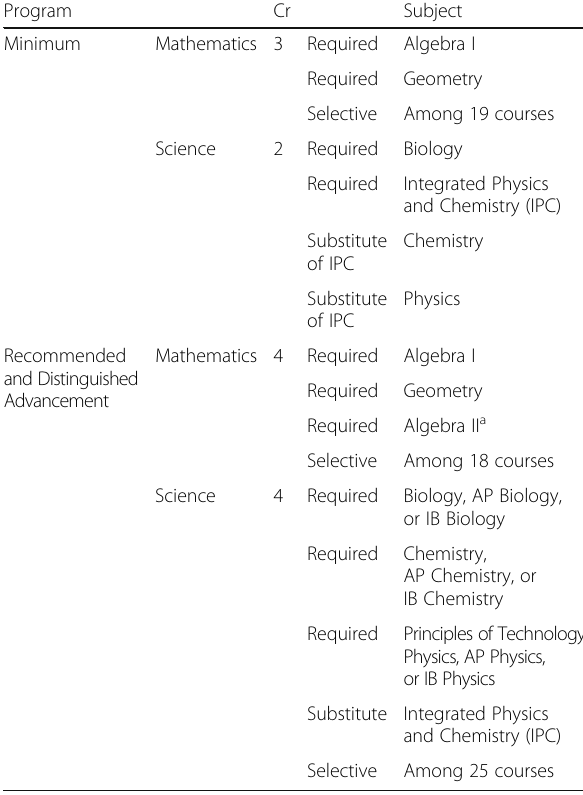
Table 1 Mathematics and science courses by types of high school curriculum for graduation in Texas (for students entering ninth grade during 2007 – 2011 school years)